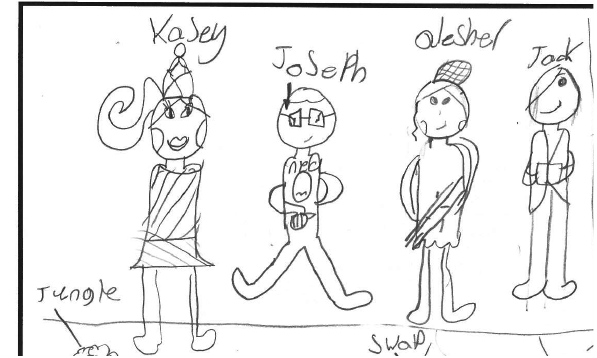
Figure 5. Example of Collectivism within a game The Large Power Distance had the highest presence within the drawings with clear evidence of rules within the game mechanics, compared to a small number of games that allowed for free play. The second highest frequency was related to Strong Uncertainty Avoidance as 5 of the games had clear punishments in the form of loosing